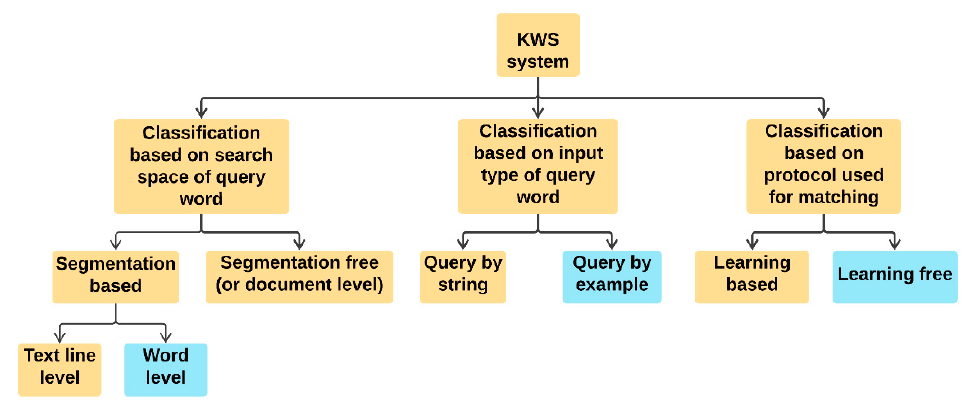
Figure 1. The taxonomy of the handwritten KWS system. The present method falls under the sub-categories shown in blue rectangular boxes.